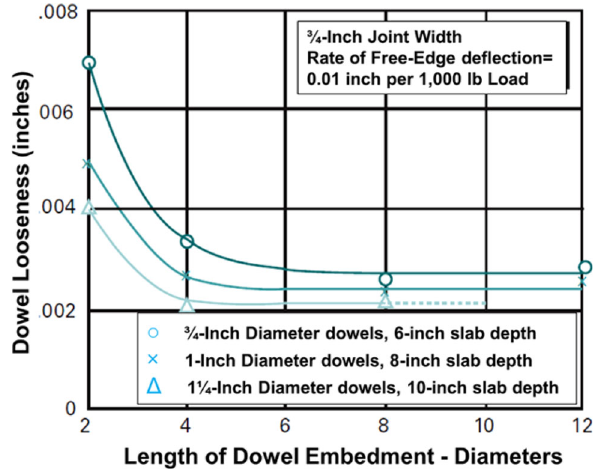
Fig. 2 Effect of dowel embedment and diameter on dowel looseness after 600,000 repetitions.